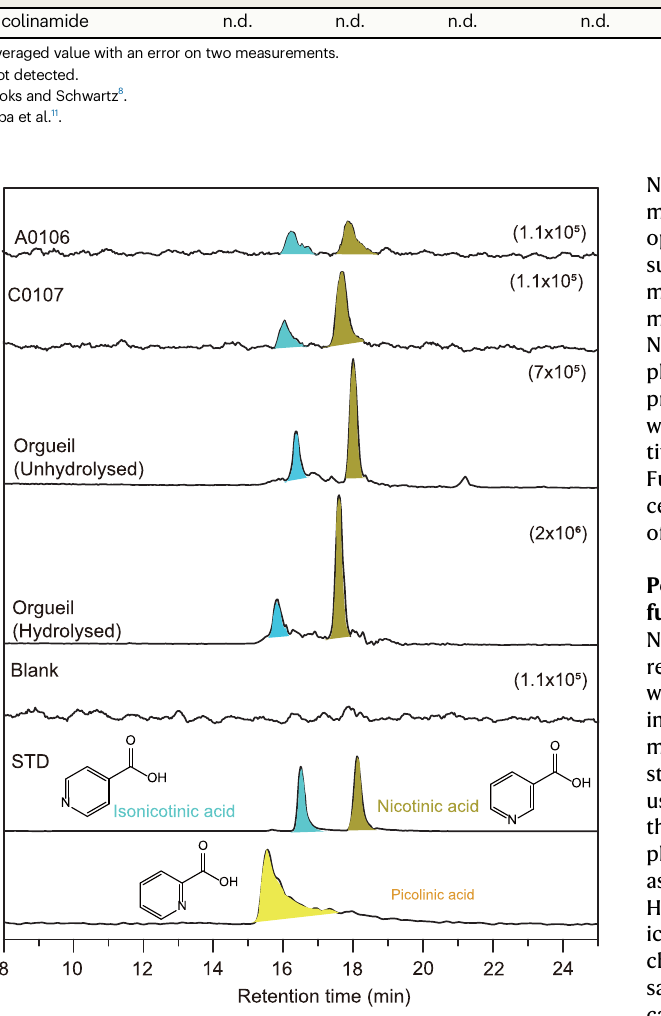
Fig.6|nicotinicacid(C 6 H 5 NO 2 )withtheirstructuralisomersdetectedinRyugu A0106 and C0107 samples and Orgueil meteorites. Mass chromatograms at the m/z of124.0393whichcorrespondstotheprotonatedionofexactmassnumberfor nicotinicacid inthe acid hydrolysate ofthe hotwater extracts from the A0106and C0107 samples. For Orgueil, mass chromatograms measured before and after acid hydrolysis were also shown. Datafor the blanksampleand authentic standards are also shown for comparison. Numbers in parenthesis represents the range for the vertical-axis in the sample chromatograms.